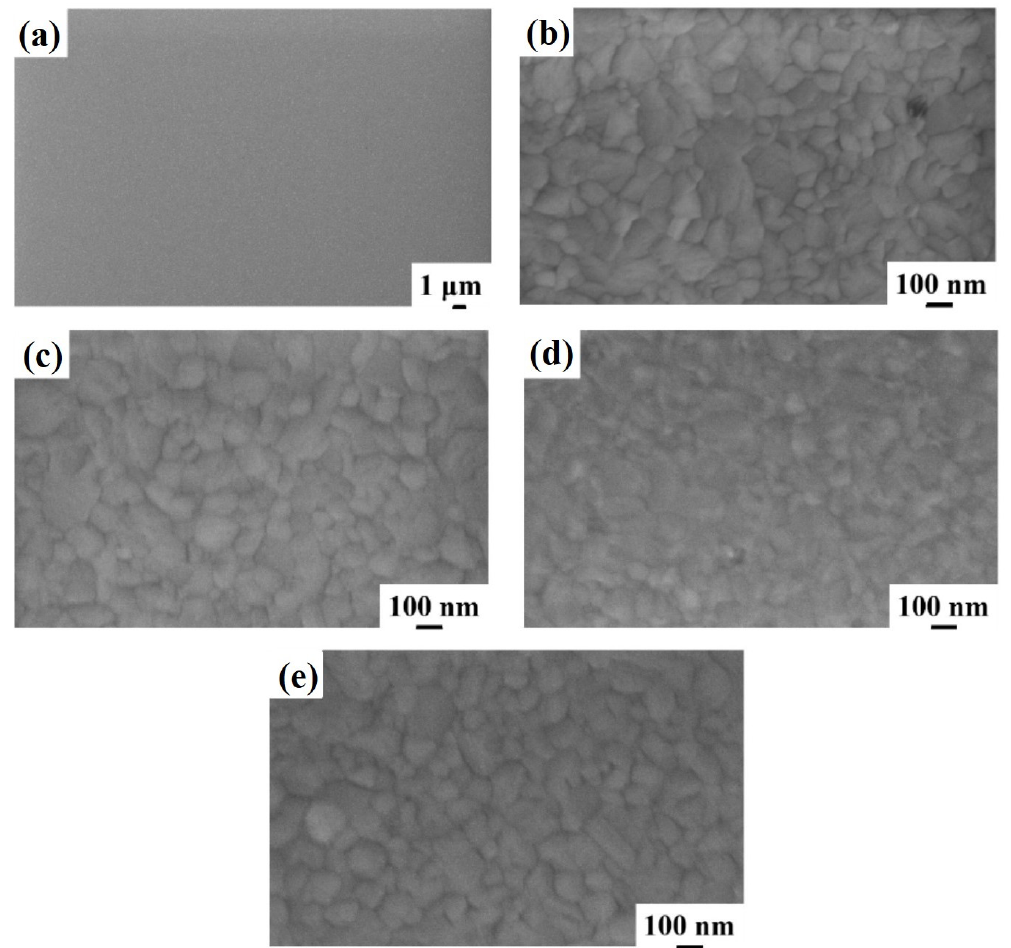
Figure 3. Representative plan-view SEM images of the Al surface for the sample: ( a , b ) 2A (Si/TiN/Al) with increasing magnification from ( a ) to ( b ); ( c ) 2E (Si/TiN/Al + 350 °C 30 min); ( d ) 2F (Si/TiN/Al + 400 °C 15 min); ( e ) 2G (Si/TiN/Al + 450 °C 15 min).